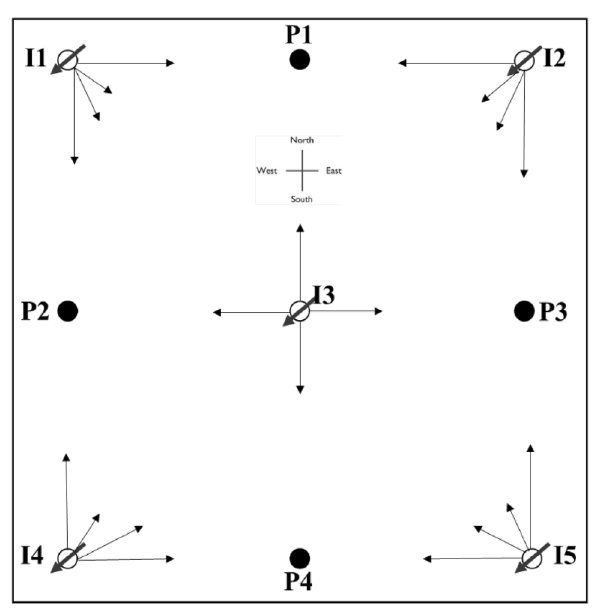
Fig. 14 Distribution of f ij in case III after applying D-CRMP. Each black arrow and its length represent the connectivity and magnitude,